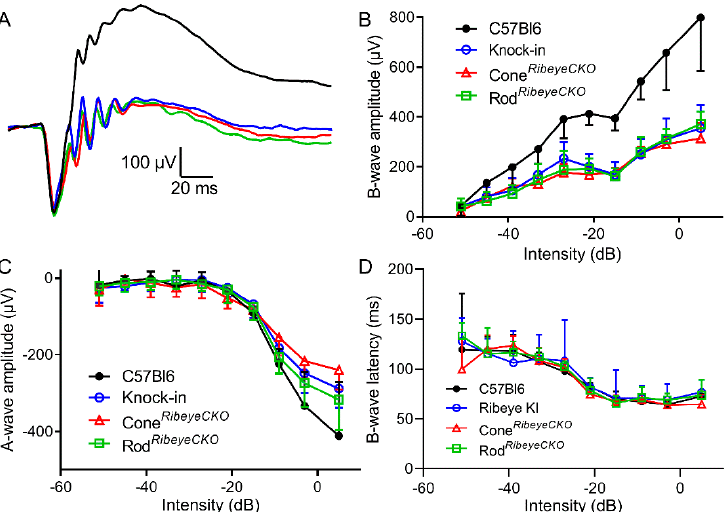
Figure 5. Scotopic ERG b-waves were reduced equally in the cone Ribeye CKO , rod Ribeye CKO , and Ribeye KI retinas. ( A ). Example waveforms. ( B ). Plot of the b-wave amplitude as a function of flash intensity measured in the C57Bl6J ( n = 4 mice), cone Ribeye CKO ( n = 5), rod Ribeye CKO ( n = 5), and Ribeye KI retinas ( n = 5). ( C ). A-wave amplitude as a function of intensity. ( D ). B-wave latency vs. intensity. The error bars show the SD.